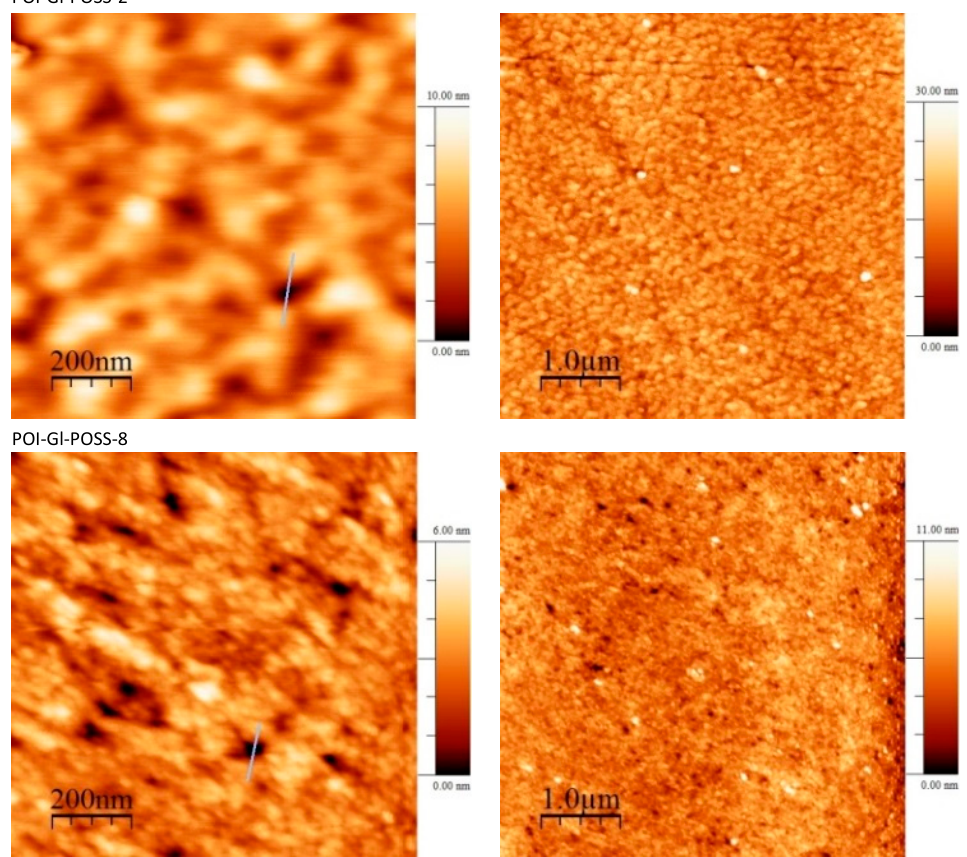
Figure 4. Surface topography images of POI-Gl-POSS via AFM.